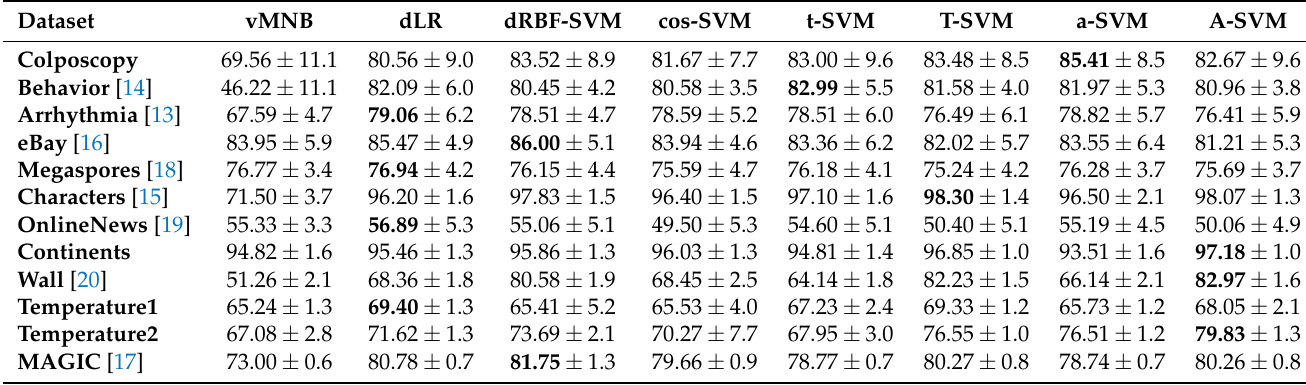
Table 1. Average accuracy and standard deviation per model on 30 runs for 12 datasets, which are presented in increasing order of their respective cardinality. The evaluated models are: Naive Bayes with von Mises distribution (vMNB), directional Logistic Regression (dLR), Multilayer Perceptron (MLP), SVM with directional